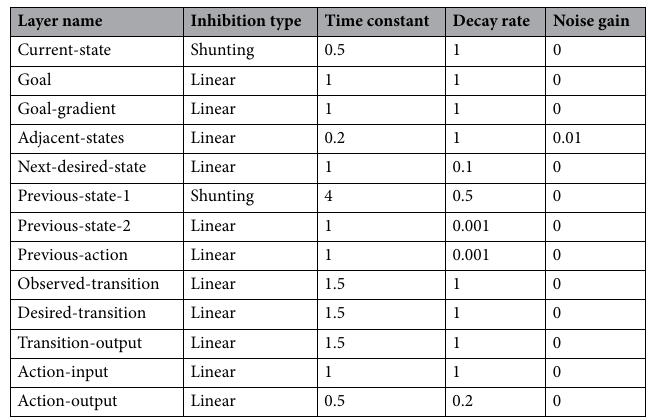
Table 2. Full list of core model layers and associated